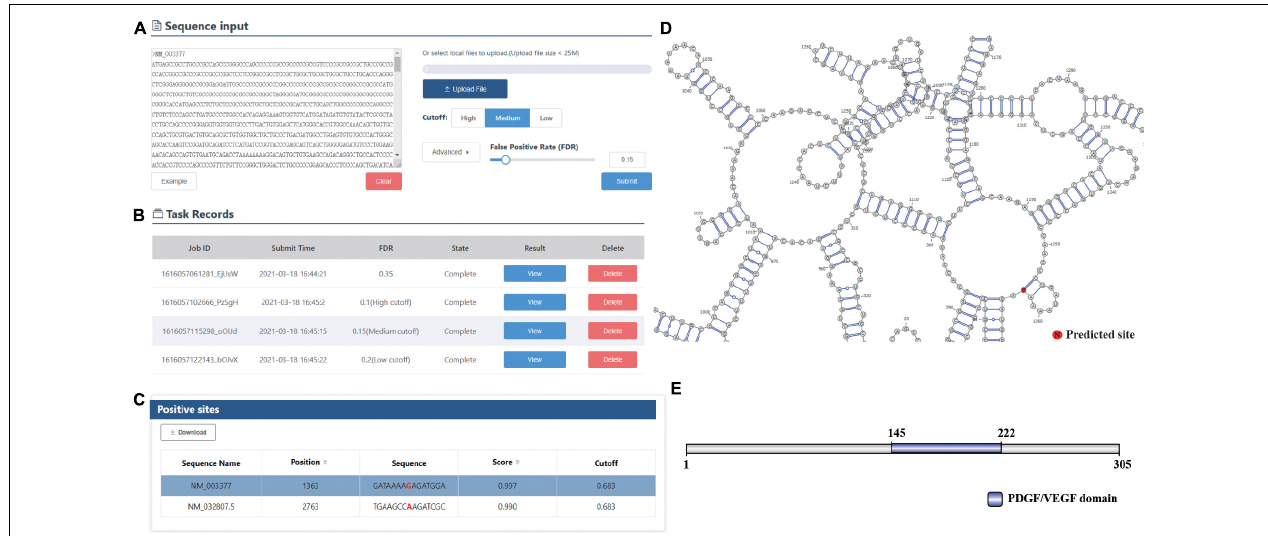
FIGURE 4 | (A) The main interface of DeepOMe. mRNA sequences can be input into the text area or uploaded as a single FASTA file. Thresholds with high, medium, and low stringencies are provided in the options panel. (B) The submitted task can be checked in the interactive table. (C) The result page of DeepOMe. Detailed information for the predicted modification sites, such as modified position, flanking sequence, prediction score, and prediction threshold, is listed in the table. (D,E) The visualization results of RNA secondary structure and protein domain organization for the input mRNA sequence using ViennaRNA, IBS, and InterProScan.